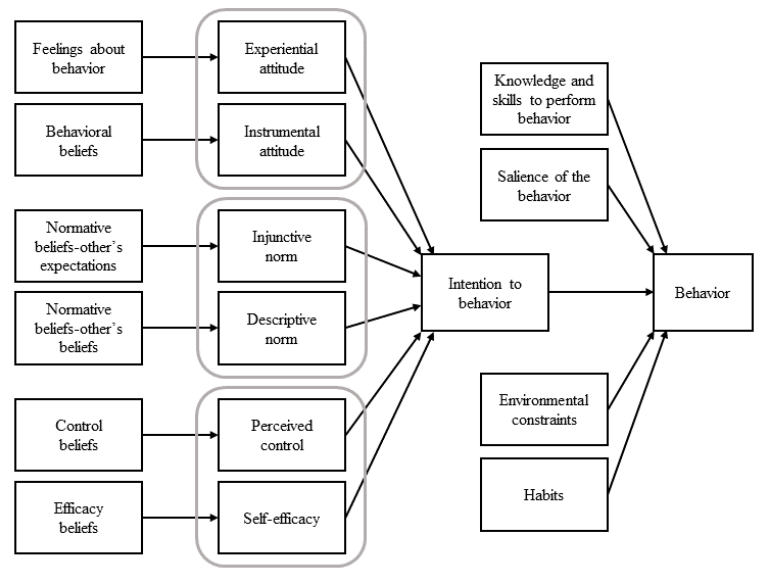
Figure 1. The integrated behavioral model [29].